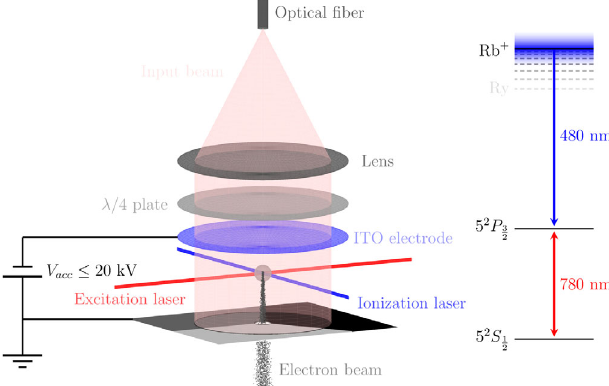
FIG. 2. Schematic representation of the ultracold electron source based on a GMOT. A two-step ionization scheme is used. The excitation and ionization laser define a volume where electrons are created. This results in an approximately Gaussian spherical ionization volume with a rms radius σ x ¼ 30 μ m. These electrons are accelerated towards the grounded grating and pass through a hole in the